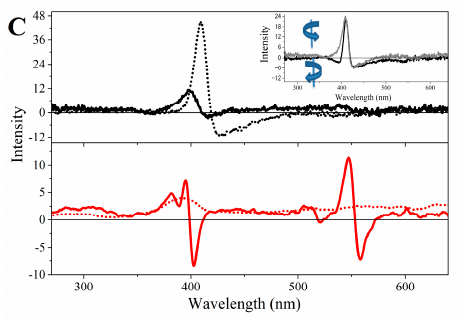
Figure 4. Comparative CD and MCD spectra of Fe(III) and Cu(II)MP-11 in homogeneous and heterogeneous media. ( A ) HEPES buffer. Left panel corresponds to positive and negative λ max at increased values of the external magnetic field (from 0.005 to 0.9965 T). Black and red symbols correspond to (Fe(III) and Cu(II), respectively. Right panels, depicted the CD spectra (dotted lines) of Fe(III) (black lines) and Cu(II)MP-11 (red lines) superimposed by the corresponding MCD spectra (solid lines); ( B ) CTAB micelles. Left panel corresponds to positive and negative λ max at increased values of the external magnetic field (from 0.005 to 0.9965 T). Black and red symbols correspond to (Fe(III) and Cu(II), respectively. Right panels, depict the CD spectra (dotted lines) of Fe(III) (black lines) and Cu(II)MP-11 (red lines) superimposed by the corresponding MCD spectra (solid lines) and ( C ) DODAB LUVs. Upper and lower panels show the CD spectra (dotted lines) of Fe(III) (black lines) and Cu(II)MP-11 (red lines) superimposed by the corresponding MCD spectra (solid lines). In the upper panel of C, the inset shows a non-typical equally intense band obtained at positive (gray line) and negative (black line) magnetic fields. The spectra were recorded with 20 µM MP-11 using a 0.1 cm quartz cuvette at 25 °C.